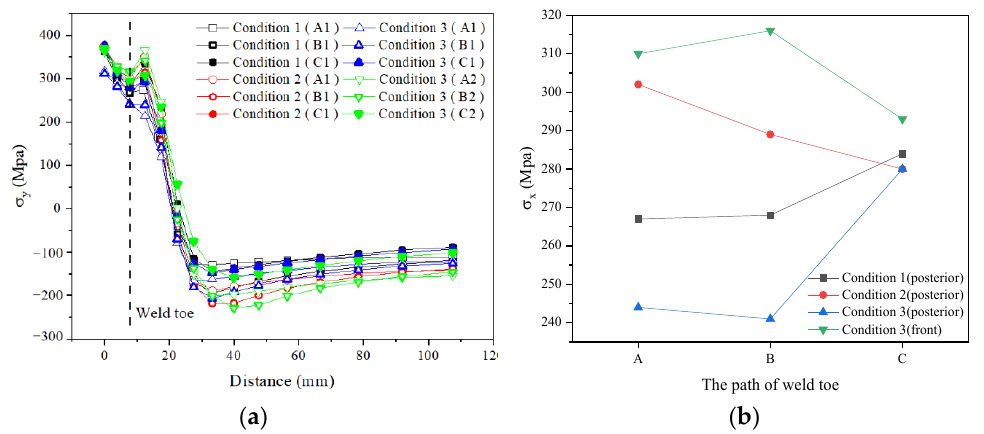
Figure 26. Residual stress distribution of σ y in different welding conditions. ( a ) Along the path direction; ( b ) Position of weld toe.